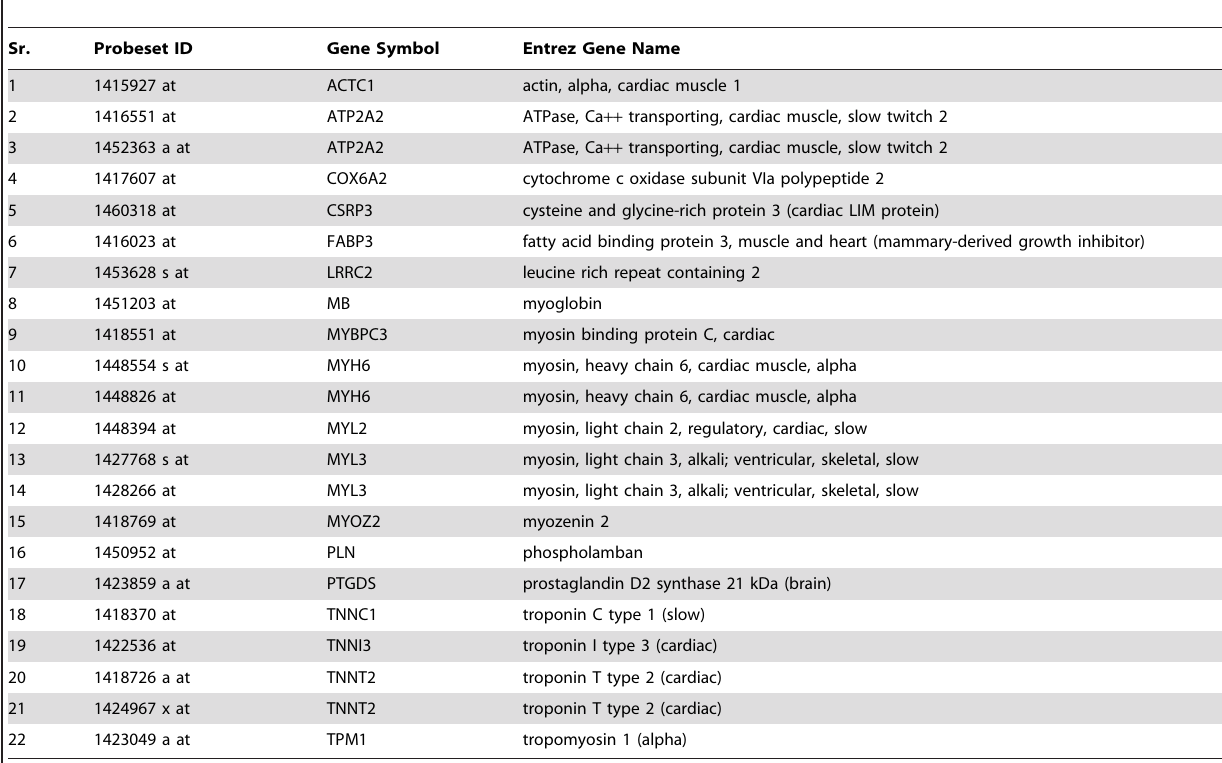
Table 10. Heart 1 heart 4 cluster 1. Common probesets between the top one hundred most influential probesets in the heart 1 cluster and 20 mg/kg dosage cluster (cluster 1) of the heart 4 dataset. Sr.